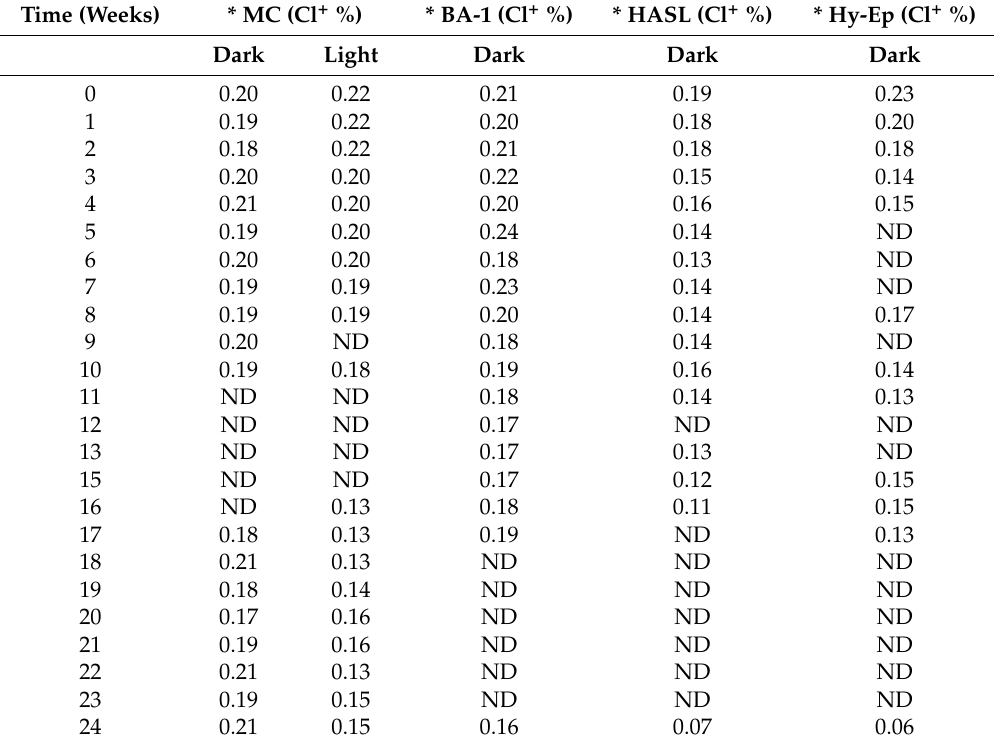
Table 1. Storage stability of MC, BA-1-Cl, HASL-Cl, and Hy-Ep-Cl under dark and fluorescent light